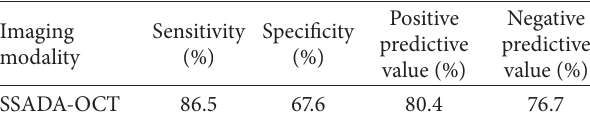
Table 2: Sensitivity, specificity, and predictive value of SSADA- OCTA in detecting neovascular age-related macular